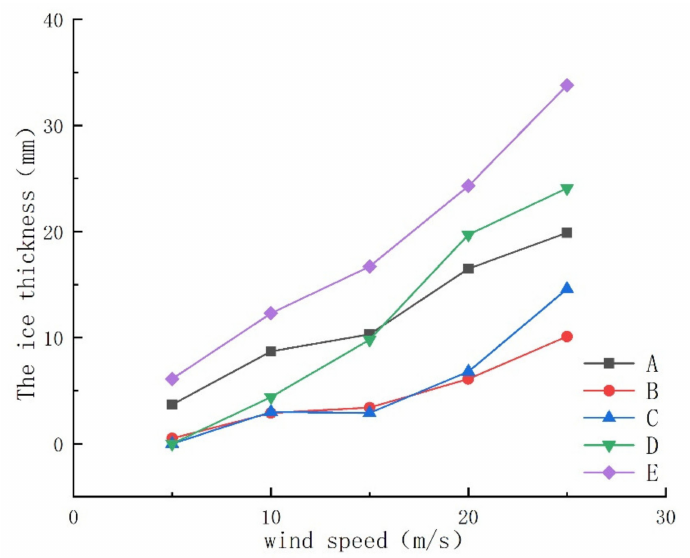
Figure 6. The changes of ice thickness at different wind